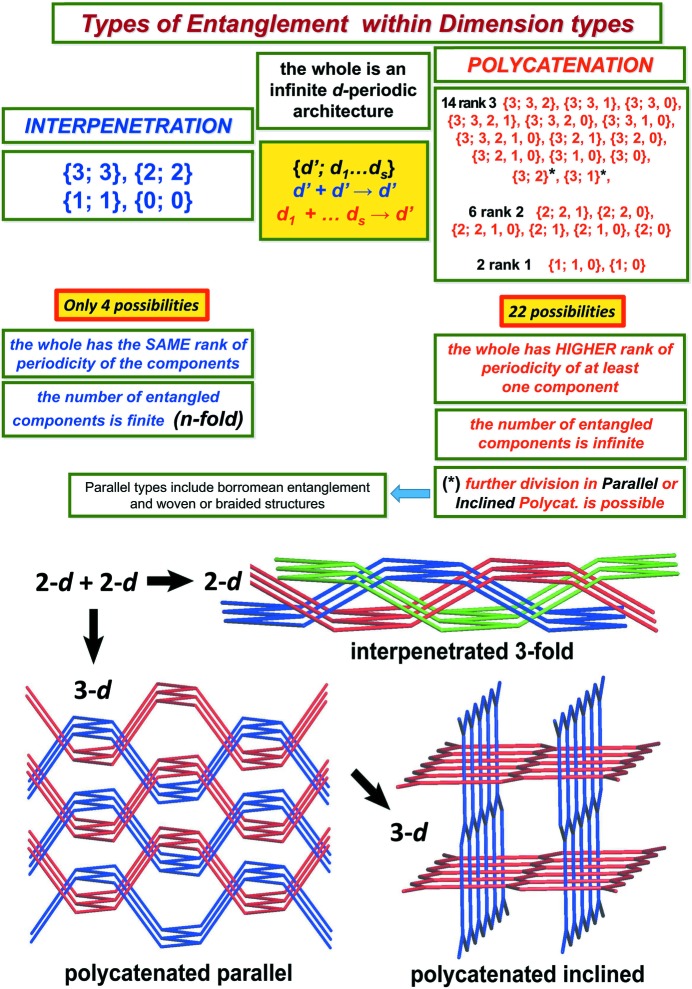
Dimension type and polycatenation.